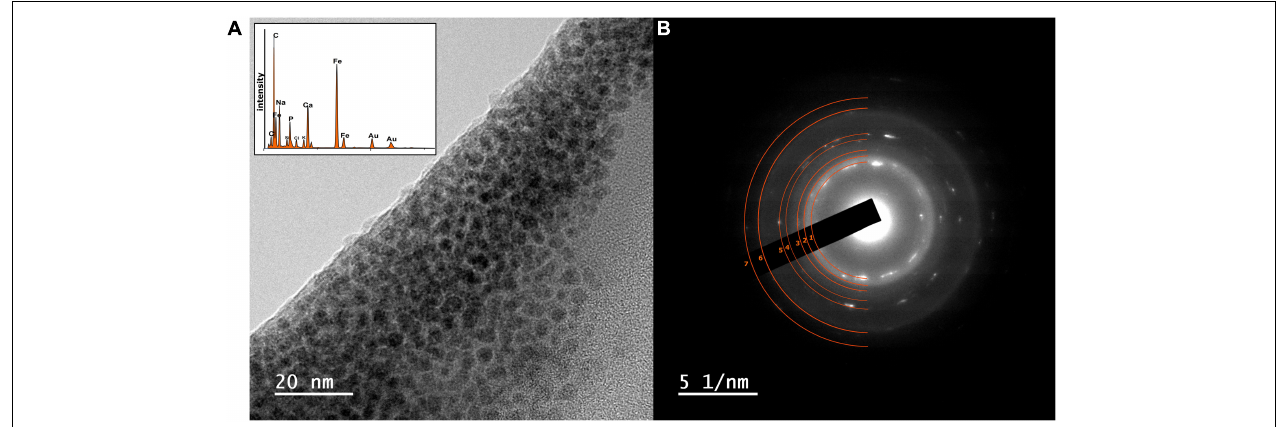
FIGURE 3 | (A) TEM image of nanoparticulate magnetite with EDAX data inset showing Fe peaks of high relative intensity (B) corresponding SAED pattern from a sample taken from the high-citrate Fe(III)-reducing microcosm experiments at initial pH 11.7. The SAED pattern (B) from the magnetite particles in (A) , have the index for magnetite overlaying the pattern (d-spacing values are provided in Supplementary Figure 5 and Supplementary Table 3 ; Sun et al., 2017).